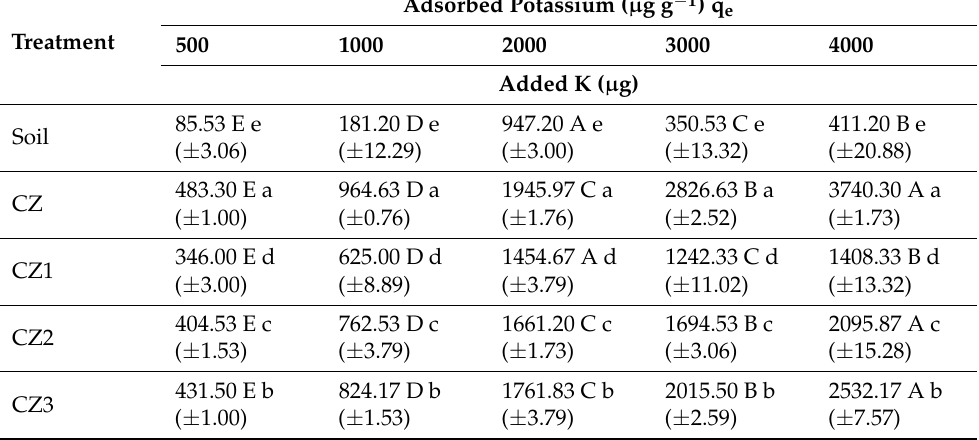
Table 10. Interactive effects of the different potassium concentrations and treatments (Soil only, clinoptilolite zeolite only, and soil with different amounts of clinoptilolite zeolite) on the amounts of potassium adsorbed.